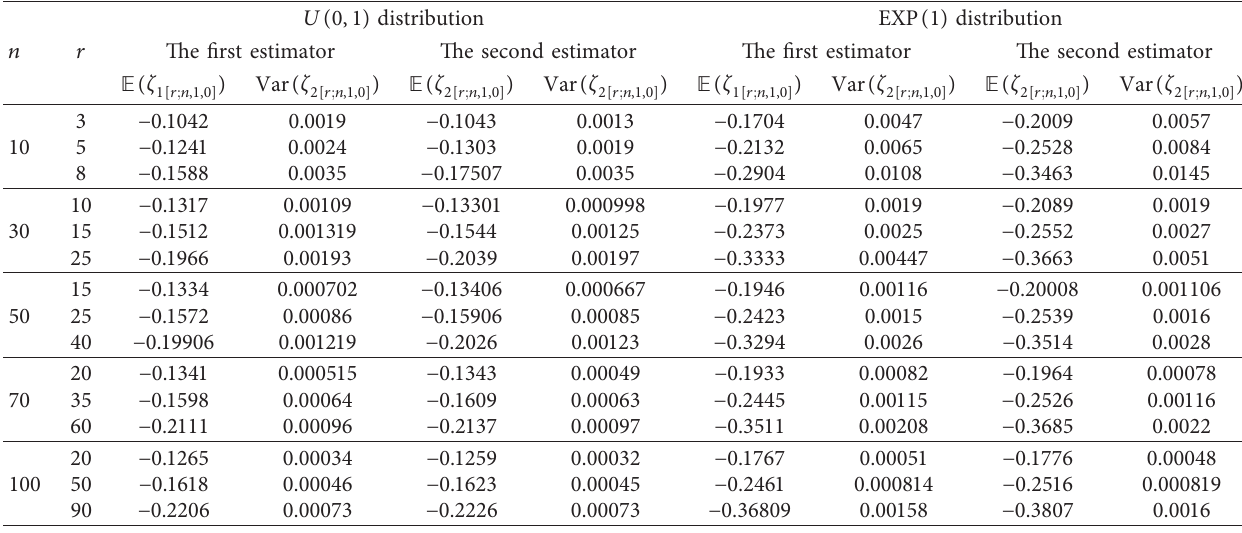
Table 1: Mean and variance of the empirical residual extropy of concomitants of order statistics, α � 0 . 8.